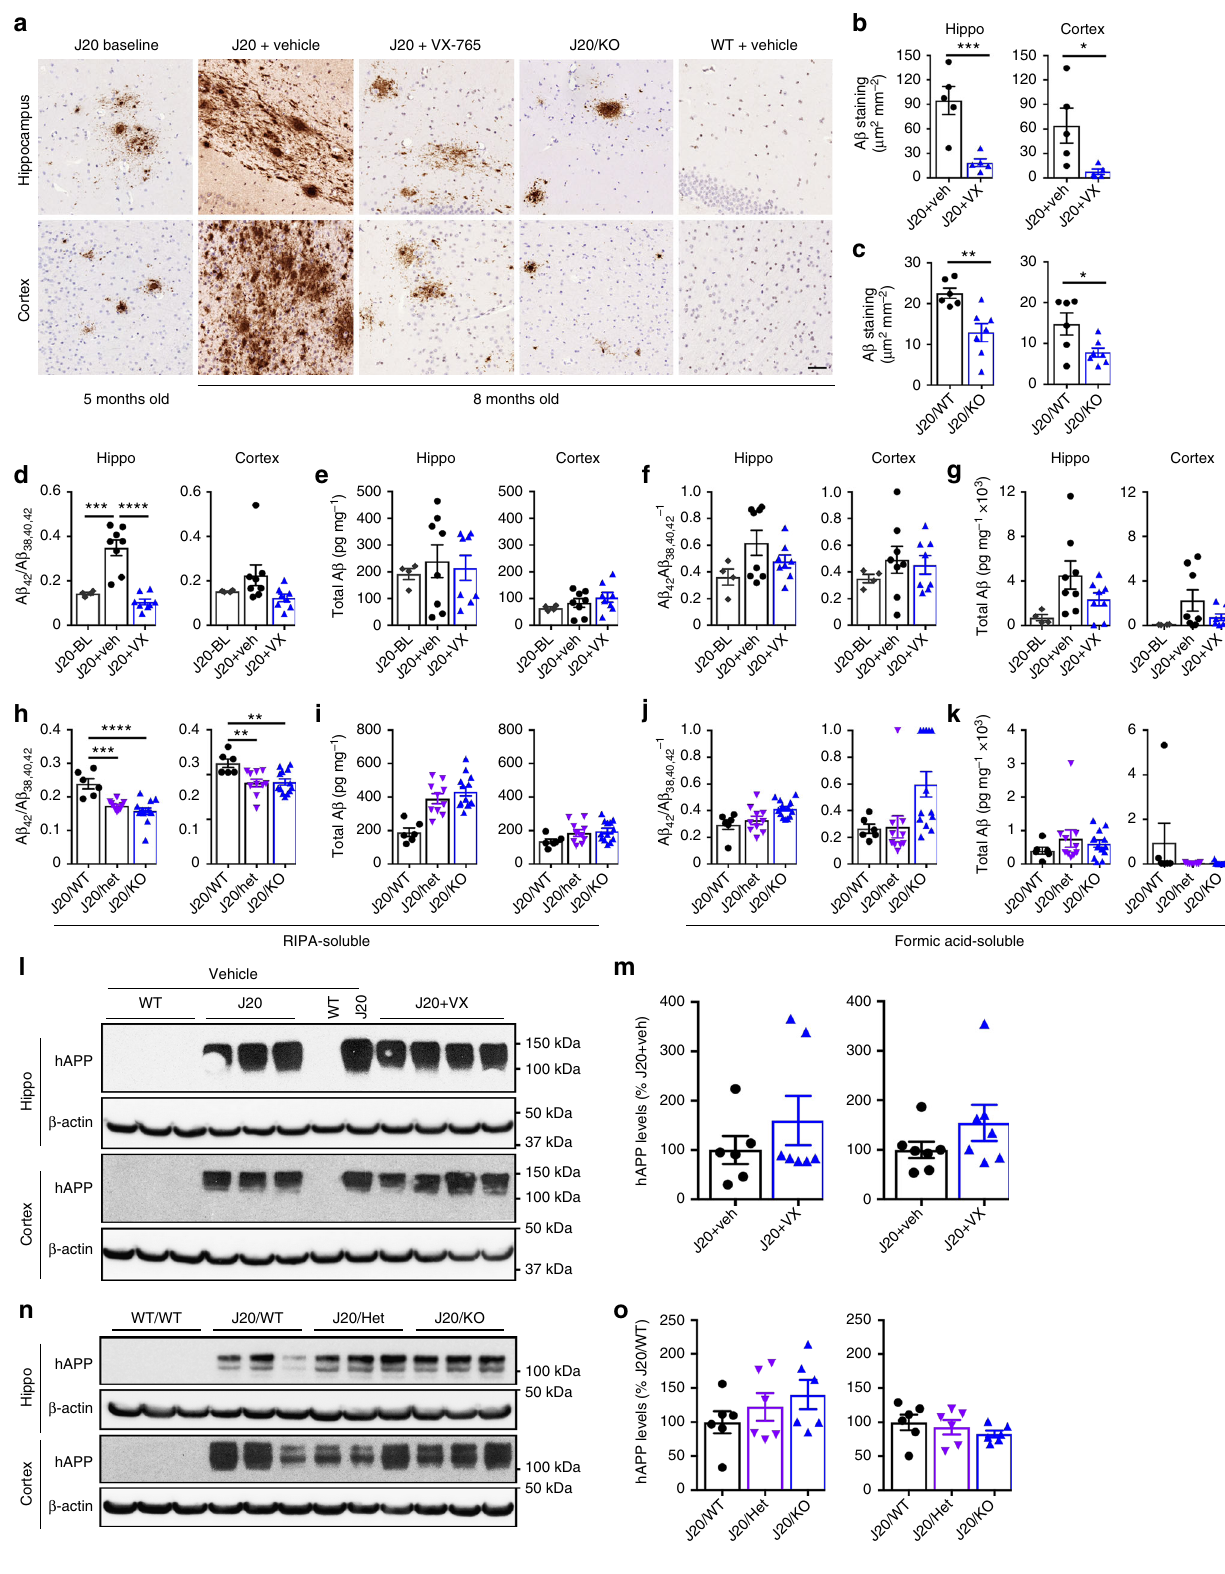
Discussion These results strongly indicate that VX-765 is a promising drug against AD. Our idea of using Casp1 as a therapeutic target is based on the identi fi cation of the Nlrp1-Casp1-Casp6